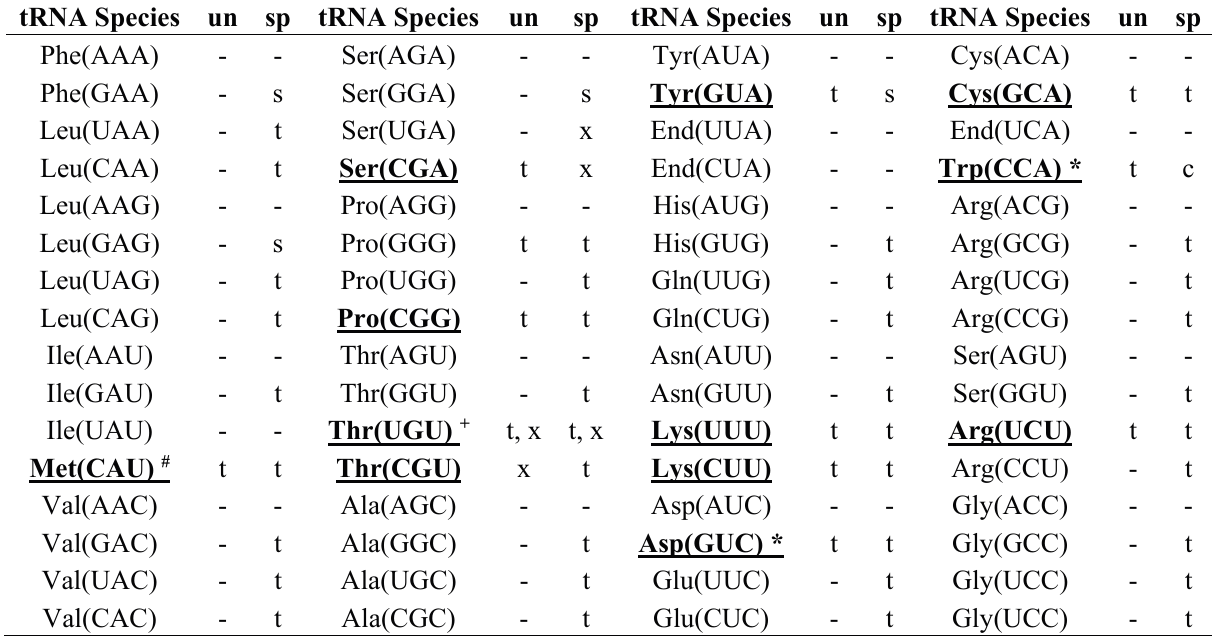
Table 1. Summary of actual A. pernix K1 tRNAs confirmed by experimental identification of representative cDNAs